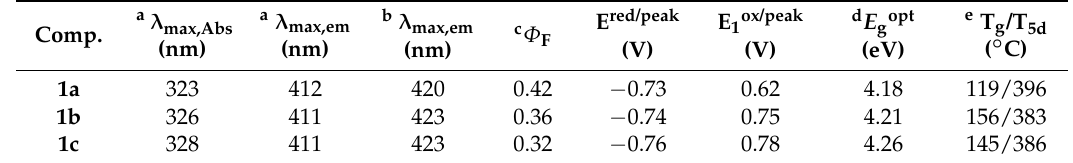
Table 1. Photophysical, physical, and electrochemical data for 1a – c